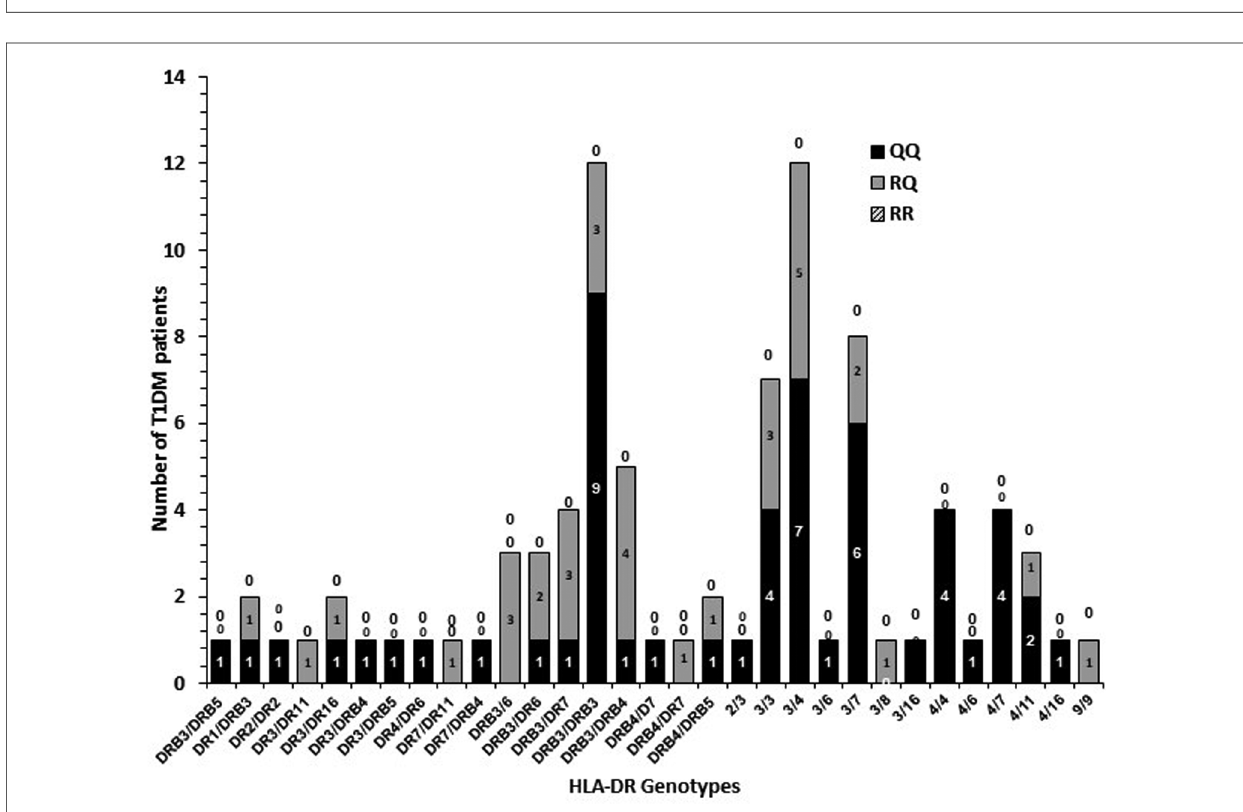
FIGURE 6 Co-inheritance of IL13 gene p .(Arg130Glu; rs20541) polymorphism genotypes with HLA-DR genotypes in Kuwaiti T1DM patients. “ 0 ” above the bars indicate the absence of a particular genotype. The shaded bars show the co-inheritance with various HLA-DR